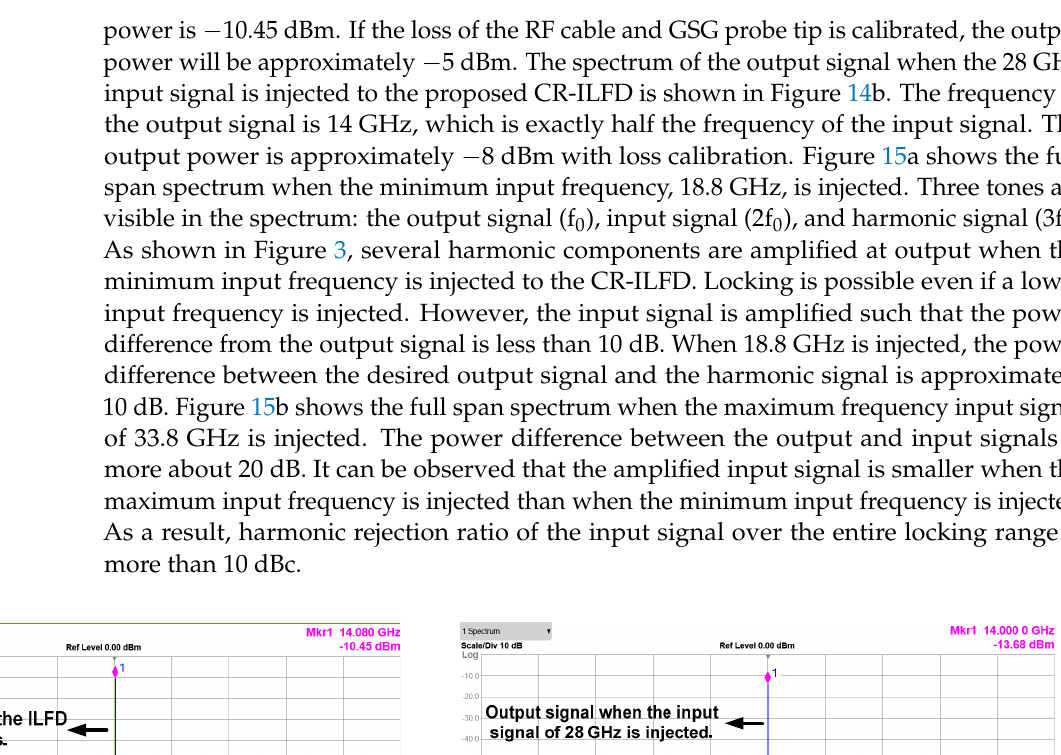
Figure 14. Spectrums of the output signal ( a ) when the proposed CR-ILFD self-oscillates; ( b ) when the proposed CR-ILFD is locked with a 28 GHz injection signal.